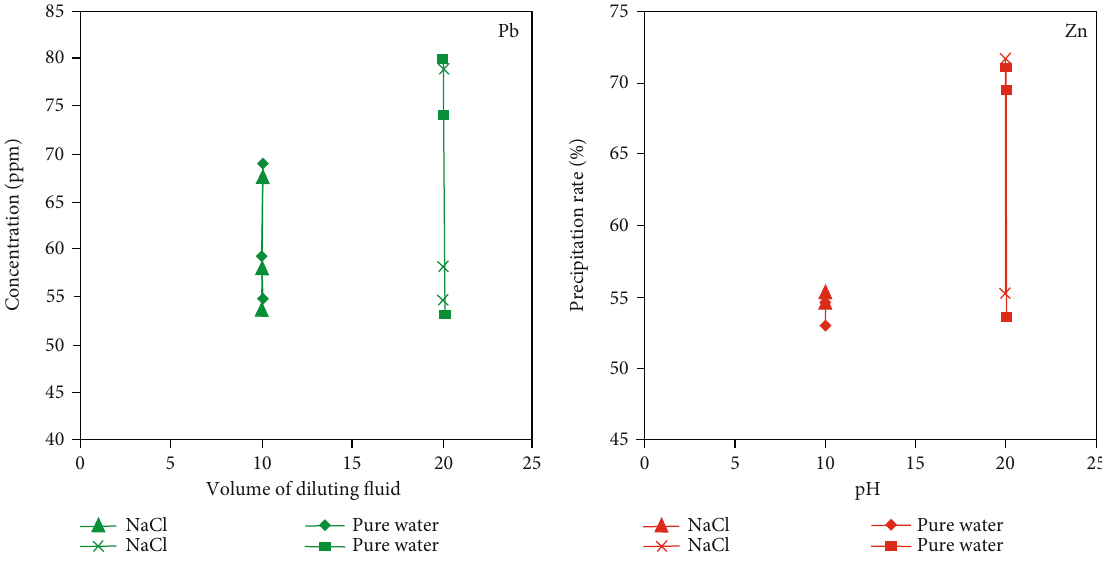
Figure 5: Precipitation rates for the dilution